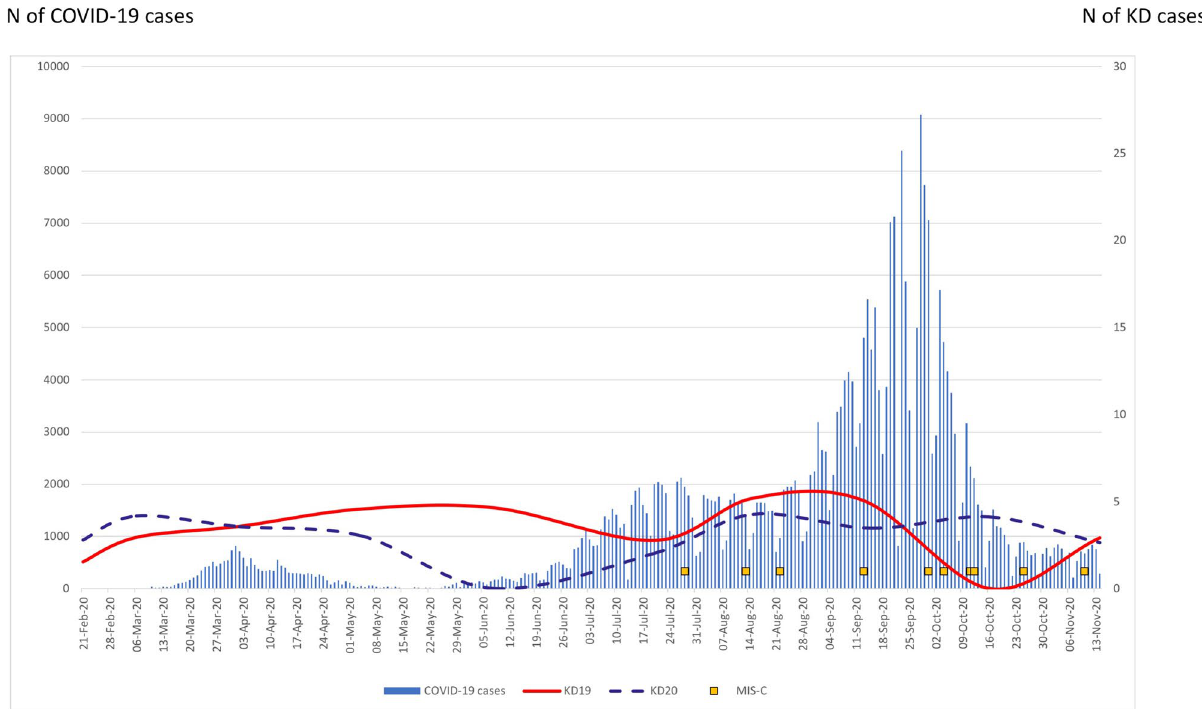
Figure 1. Kawasaki Disease (KD) rates per 1000 admissions in the two medical centers, in 2019 (solid line) and 2020 (dashed line), compared with number of COVID-19 cases diagnosed in Israel (bars; COVID-19 numbers obtained from Israel Ministry of Health data at: www. data. gov. il). multisystem inflammatory syndrome in children (MIS-C) cases represented by